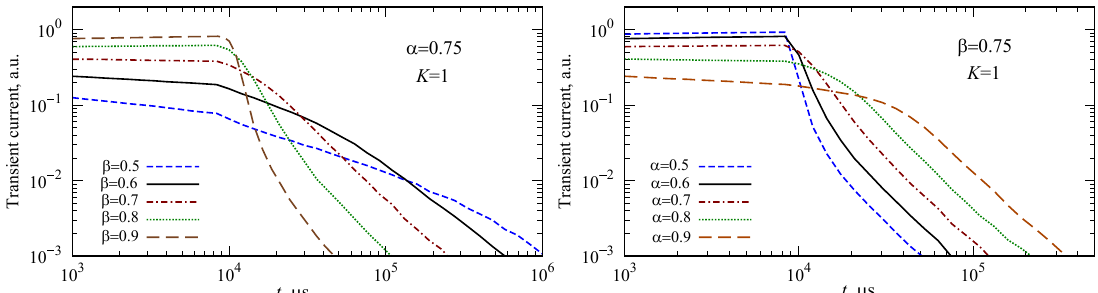
Figure 6. Transient current curves for different values of α (cid:54) = β and K